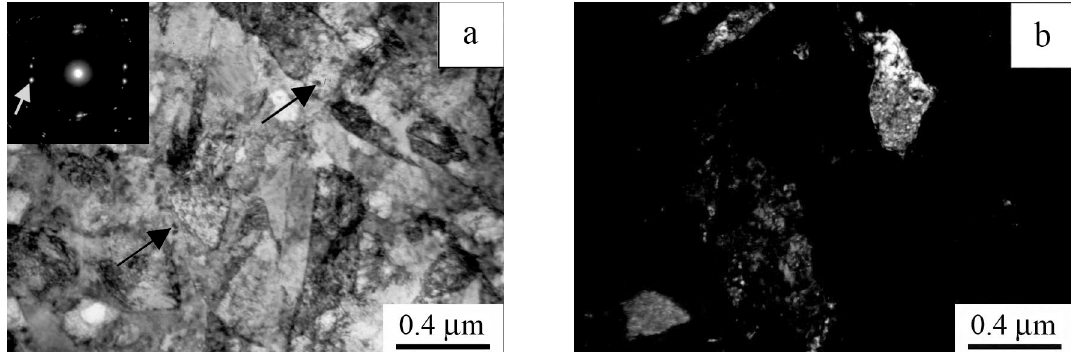
Figure 3. Microstructures [( a ) is the bright-field image and ( b ) is the dark-field image in (002) α -Zr reflection] and ( c ) parts of the diffraction pattern of the UFG Zr–1Nb alloy after pressing, with the change of the deformation axis and a gradual temperature decrease.